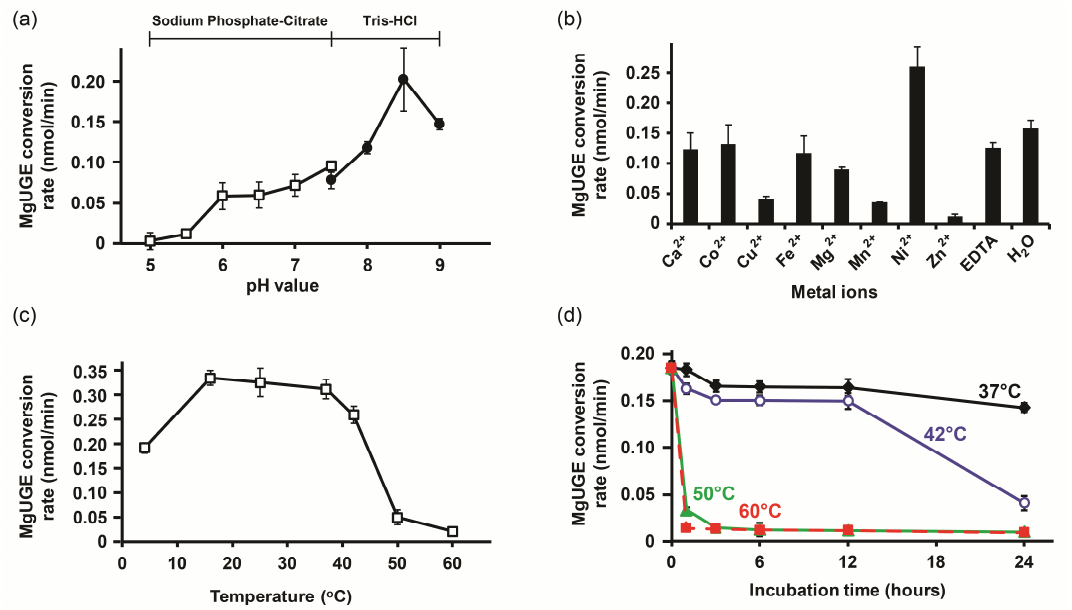
Figure 2. Biochemical characterization of MgUGE. ( a ) pH dependency of recombinant MgUGE; ( b ) Impact of metal ions and ethylenediaminetetraacetic acid (EDTA) on the enzymatic activity of MgUGE; ( c ) MgUGE activity at various incubation temperatures; and ( d ) Thermal stability of MgUGE using multiple pre-incubation times and temperatures. The pH values of the Tris-HCl and sodium phosphate-citrate buffers represent their pH values at 22 °C. The error bars represent the standard deviations calculated from three independent experiments.